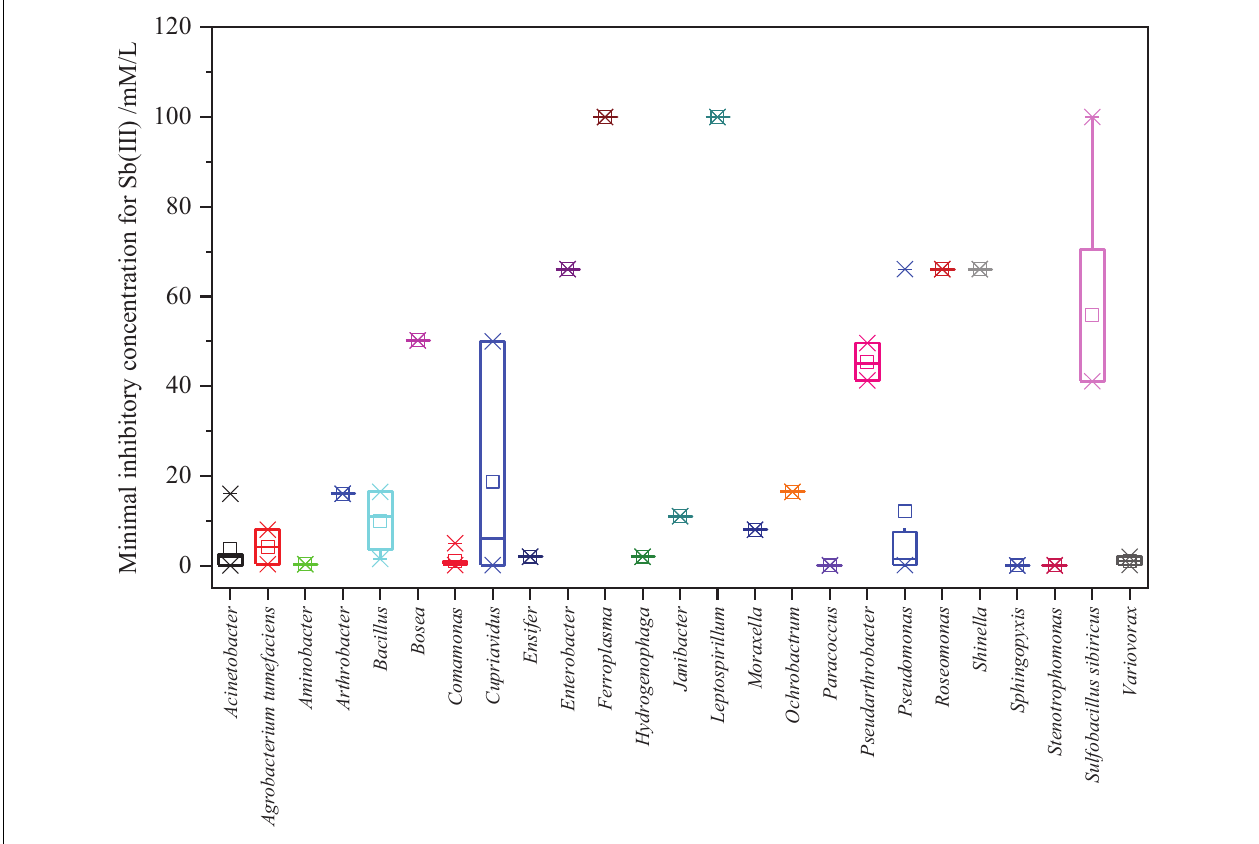
FIGURE 4 | Statistical analysis results of the MIC for Sb(III) of Sb-oxidizing bacteria.